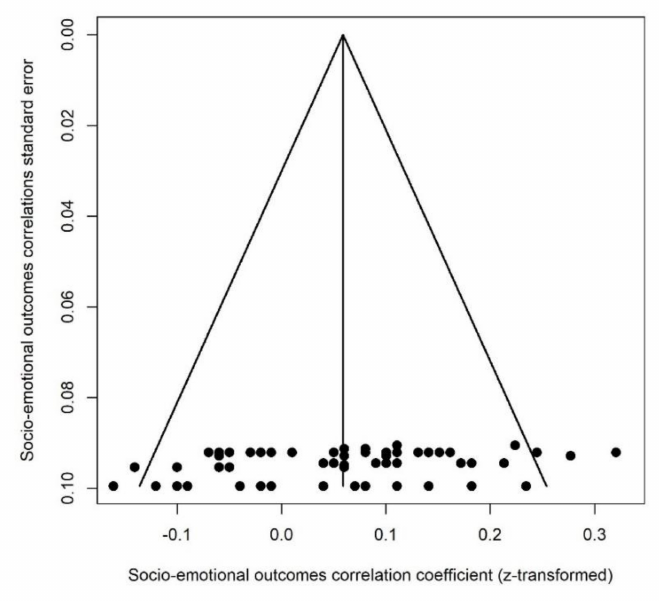
Figure 15. Socio-emotional outcomes funnel